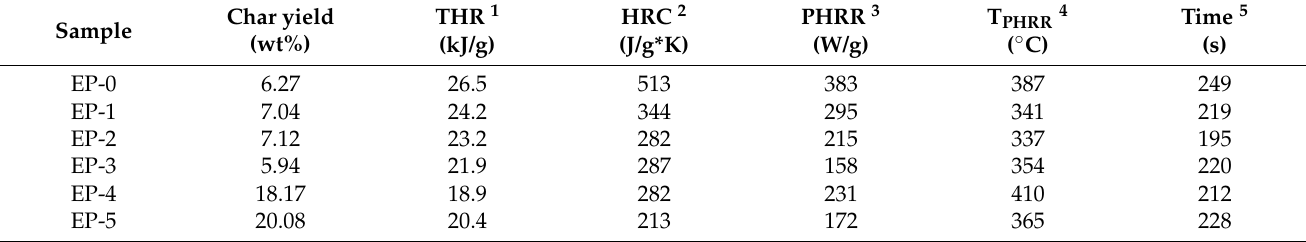
Table 3. Data obtained by MCC analysis for epoxy composites.